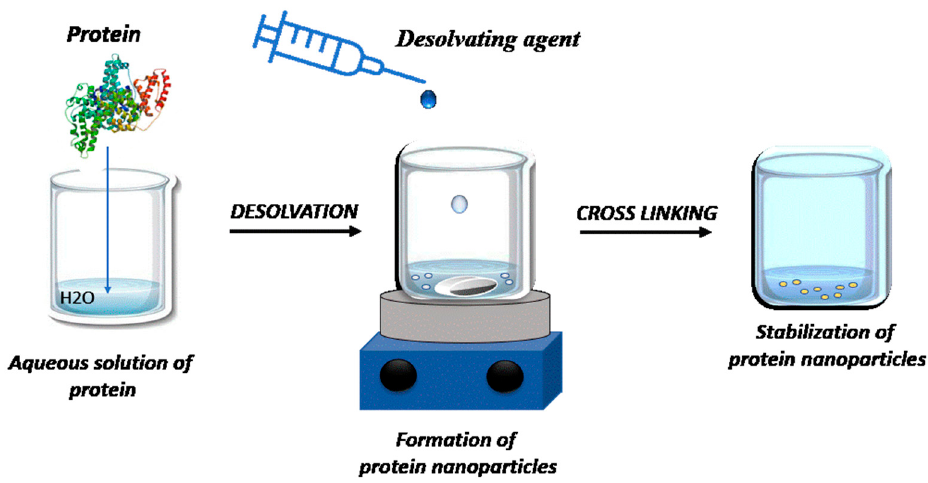
Figure 1. Schematic diagram of the desolvation method for preparing protein